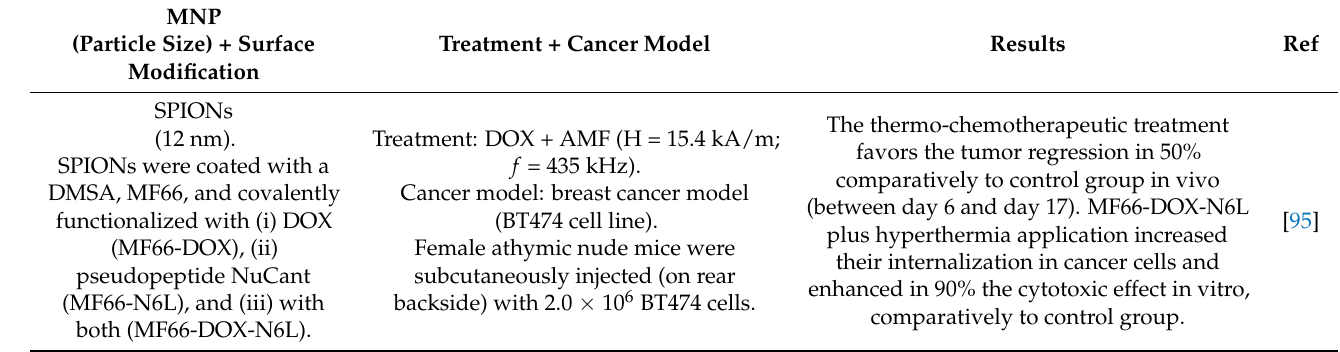
Table 2. Studies using magnetic nanoparticles (MNPs) as drug delivery systems for cancer